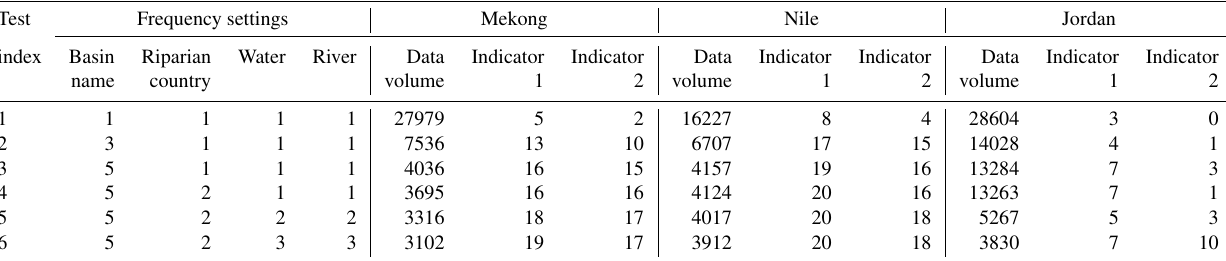
Table A1. Trial-and-error process of the frequency settings of keywords for the Mekong, Nile, and Jordan rivers.